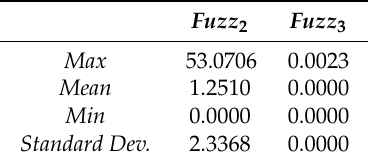
Table A1. Descriptive statistics of (cid:1832)(cid:1873)(cid:1878)(cid:1878) (cid:2870) and (cid:1832)(cid:1873)(cid:1878)(cid:1878) (cid:2871) for initial classification (Section 3).